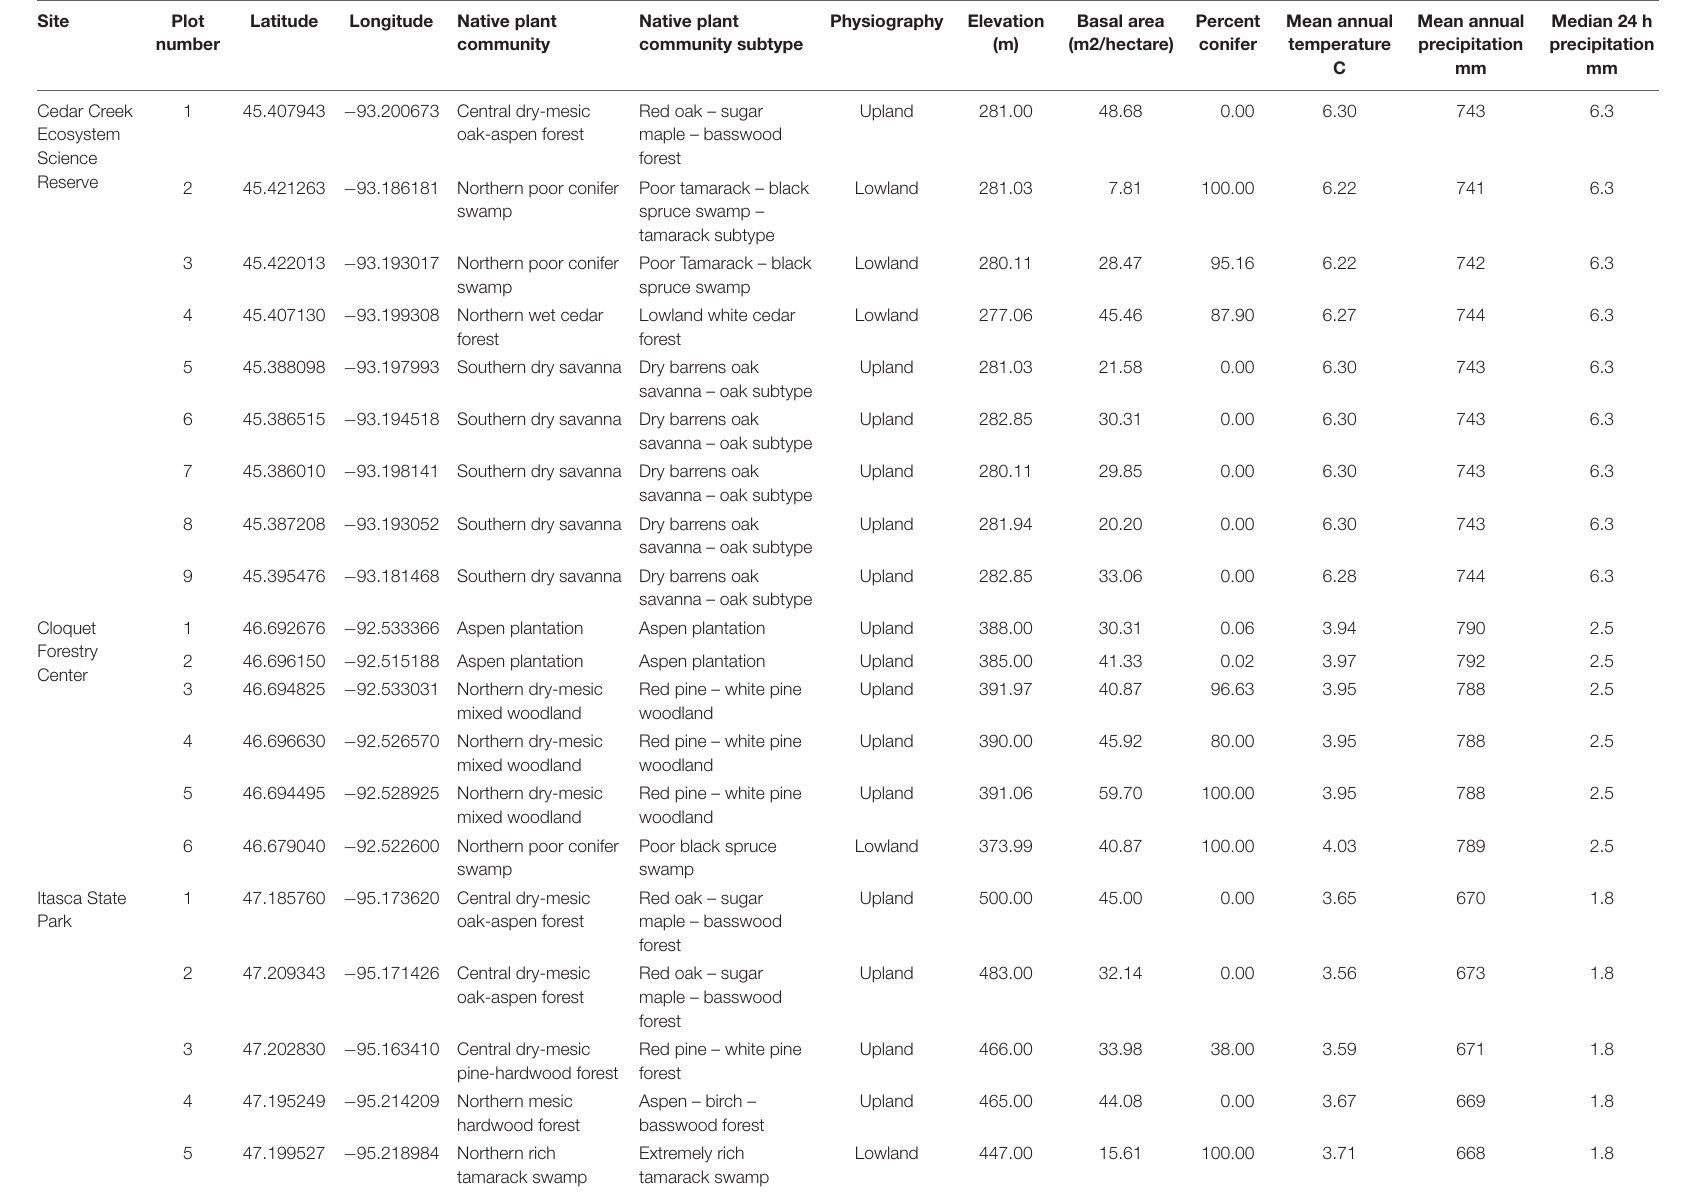
TABLE 1 | Locations and characteristics of the plots included in the